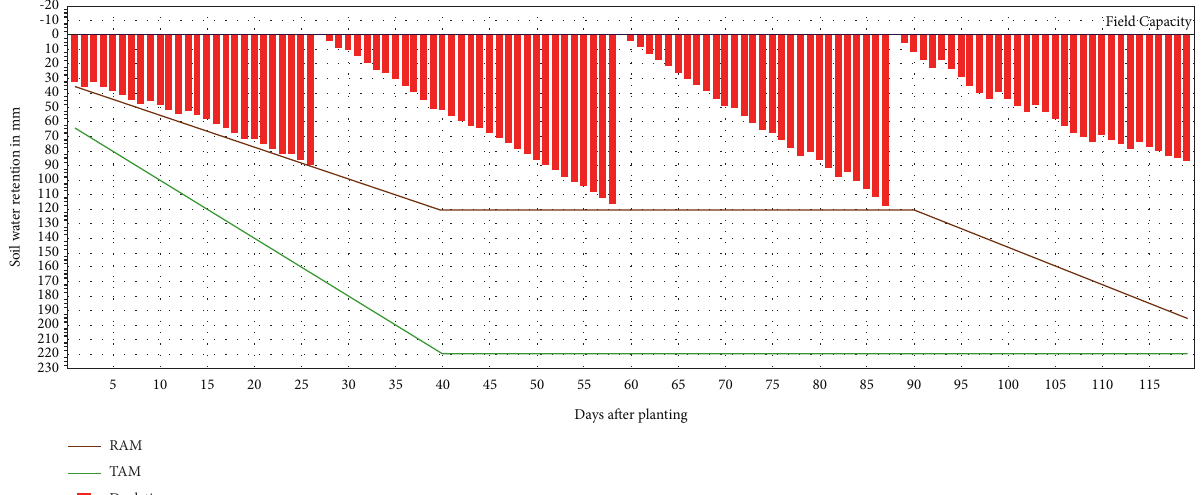
Figure 7: Color reveals the barley irrigation schedules showing RAM (brown line); TAM (green line); and water depletion (red vertical line